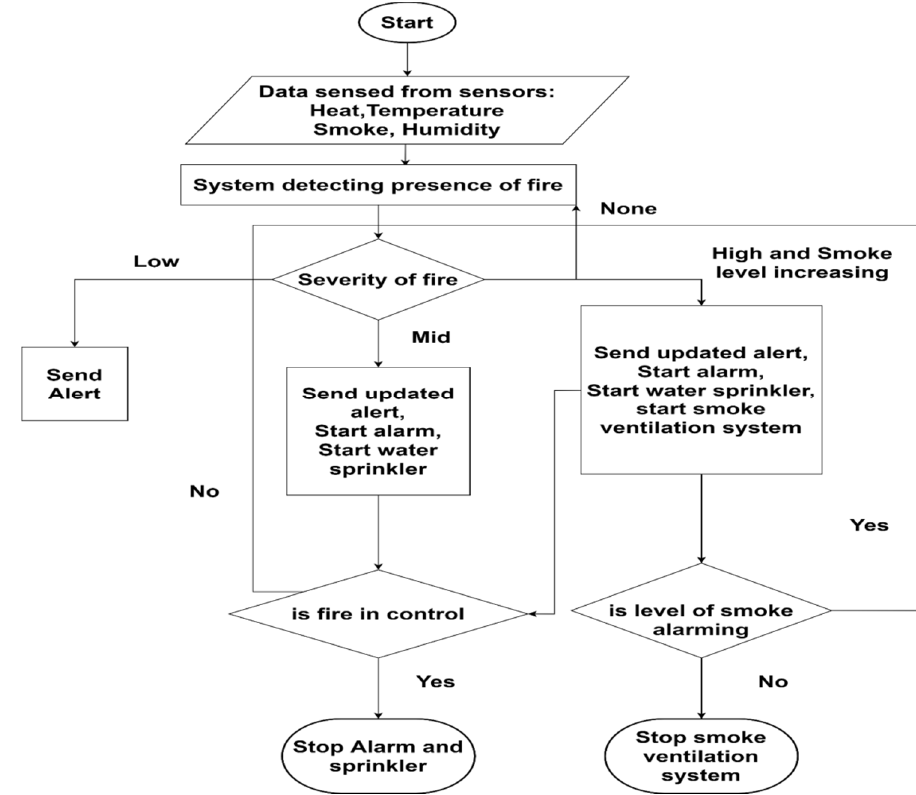
Figure 2. Flow chart for SMDD.